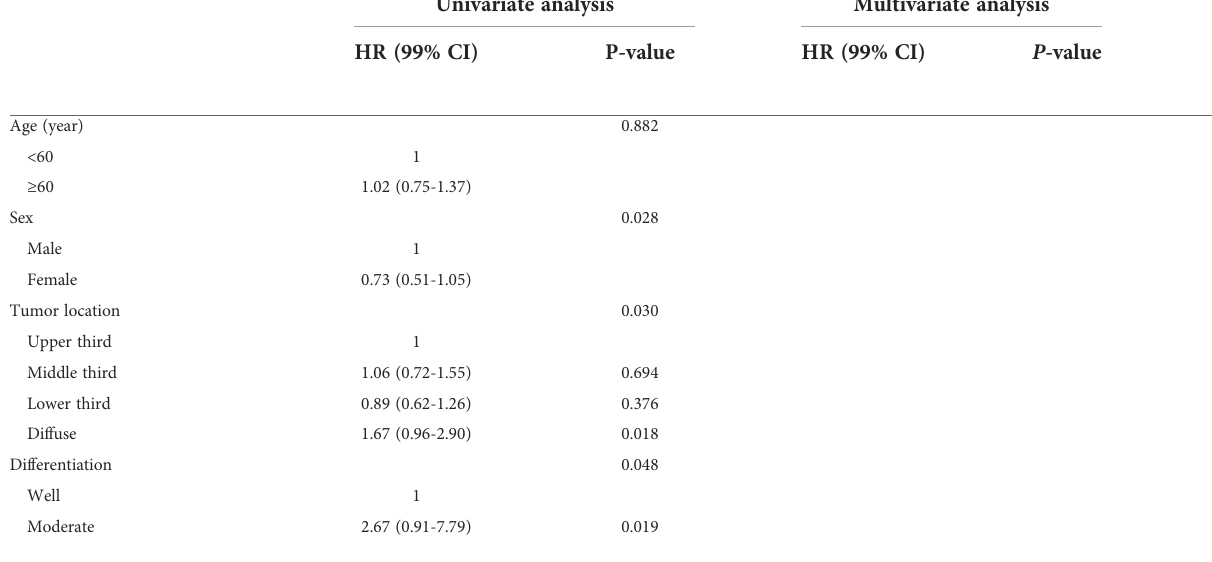
TABLE 4 Univariate and multivariate cox proportional hazard model of gastric cancer with